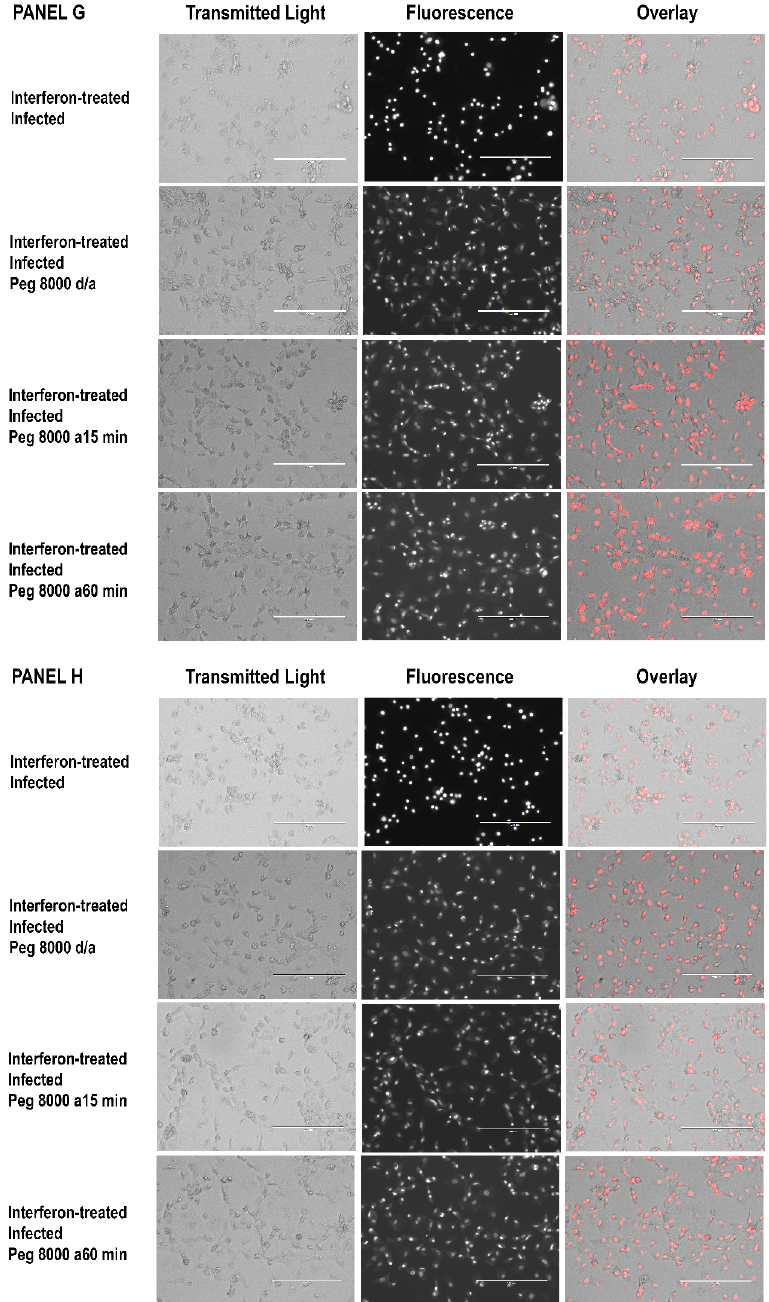
Figure 5. Results of ethidium bromide staining of untreated and IFN- γ -pretreated endothelial cells 3 to 6 h after the start of the mock infection (Panels A – D ) or after addition of R. prowazekii (Panels E – H ). d/a, PEG 8000 (15 mM) was added during the mock infection or rickettsial infection and was continuously present thereafter; a15 min, PEG 8000 was added after the 15-min centrifugation; a60 min, PEG 8000 was added 60 min after the start of the mock infection or rickettsial infection. The micrographs in all panels show duplicate cultures from a representative experiment. Figure S2 shows all images from the experiment and indicates which images are shown here. Each bar represents 200 µ m. To eliminate concern about image manipulation, all transmitted light images were captured under identical conditions, and all fluorescence images were captured under identical conditions as well. All transmitted light micrographs and all overlays were then adjusted for exposure and contrast using identical settings in Adobe Photoshop CC 2018 ®